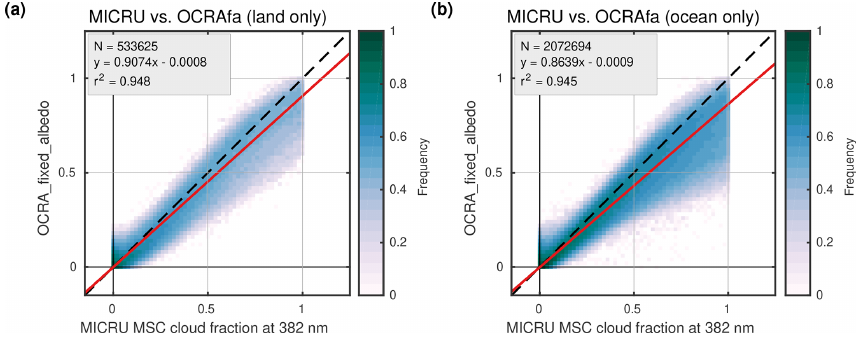
Figure 19. Comparison between MICRU MSC at 382nm and OCRA_fixed_albedo based on CF data from April 2010: measurements over (a) land and (b) ocean. This comparison applies cropped data.